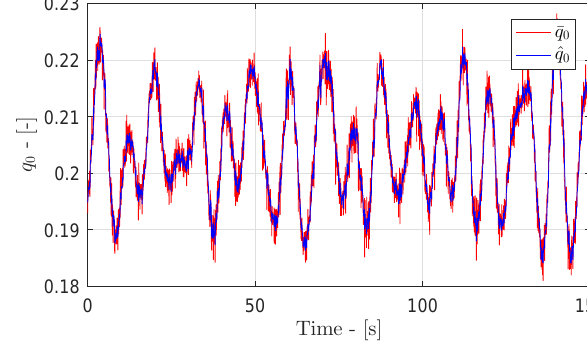
Figure 13: EQKF performance for quaternion coeffi- cient q 0 .